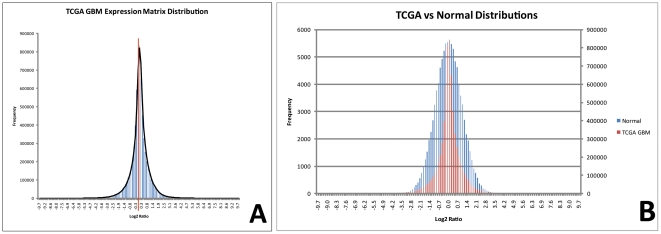
Distribution of the Complete Gene Expression Matrix for the TCGA GBM Data.A: TCGA GBM expression matrix histogram. The zero position on the abscissa is indicated with a red meridian. Careful inspection (particularly at the apex) reveals the negative skew. B: Overlay of the TCGA GBM distribution and the standard Gaussian (normal) distribution. This representation, in particular, demonstrates the leptokurtosis of the TCGA GBM data distribution. Scales of the ordinates have been adjusted to facilitate distribution overlay.